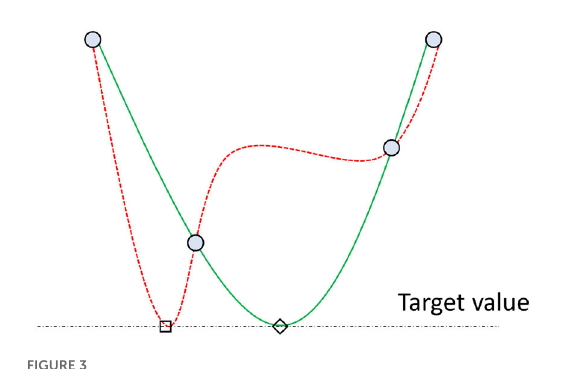
FIGURE3 Depiction of two surrogate models interpolating four points (blue circles) and reaching a target value (horizontal dashed line). The green solid-line model is considered more likely than the red dashed-line one since it is smoother. In other words, the method by Gutmann (2001) assumes that it is more likely that the point tagged with a diamond exists (green line) rather than that with a square (red line) in the real function (Costa and Nannicini, 2018).